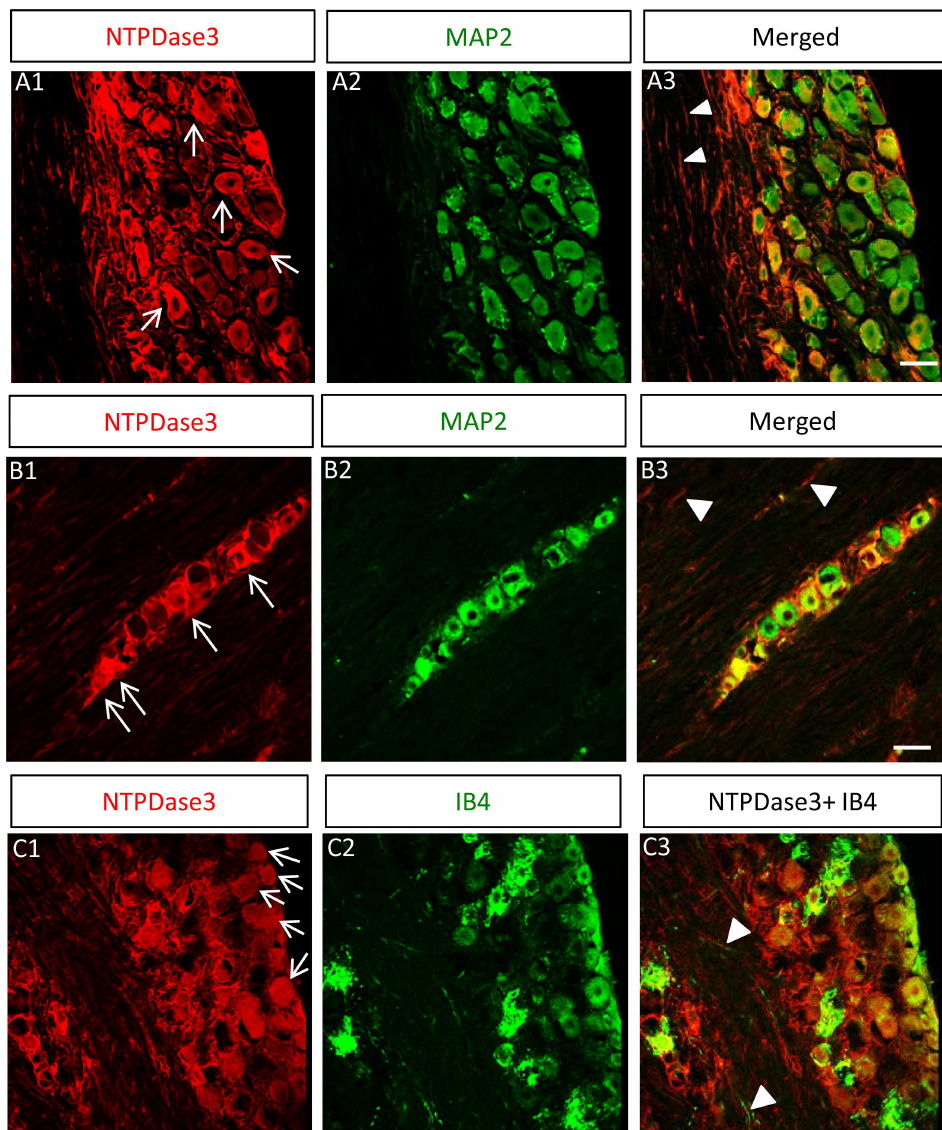
(arrows in A1) and their axonalfibers (white triangles in merged image in A3. B: Ecto-NTPDase3 is detected in trigeminalnerve trunks projectingto the brainstem. Immunostaining for NTPDase3 (B1) is co-localized